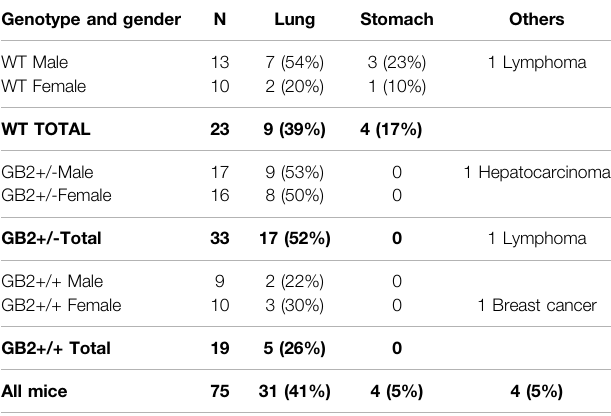
TABLE 1 | Frequency of spontaneous tumors in GSDMB2-HA knock-in mouse model (R26-GB2) and control (WT) mice. Genotype and gender